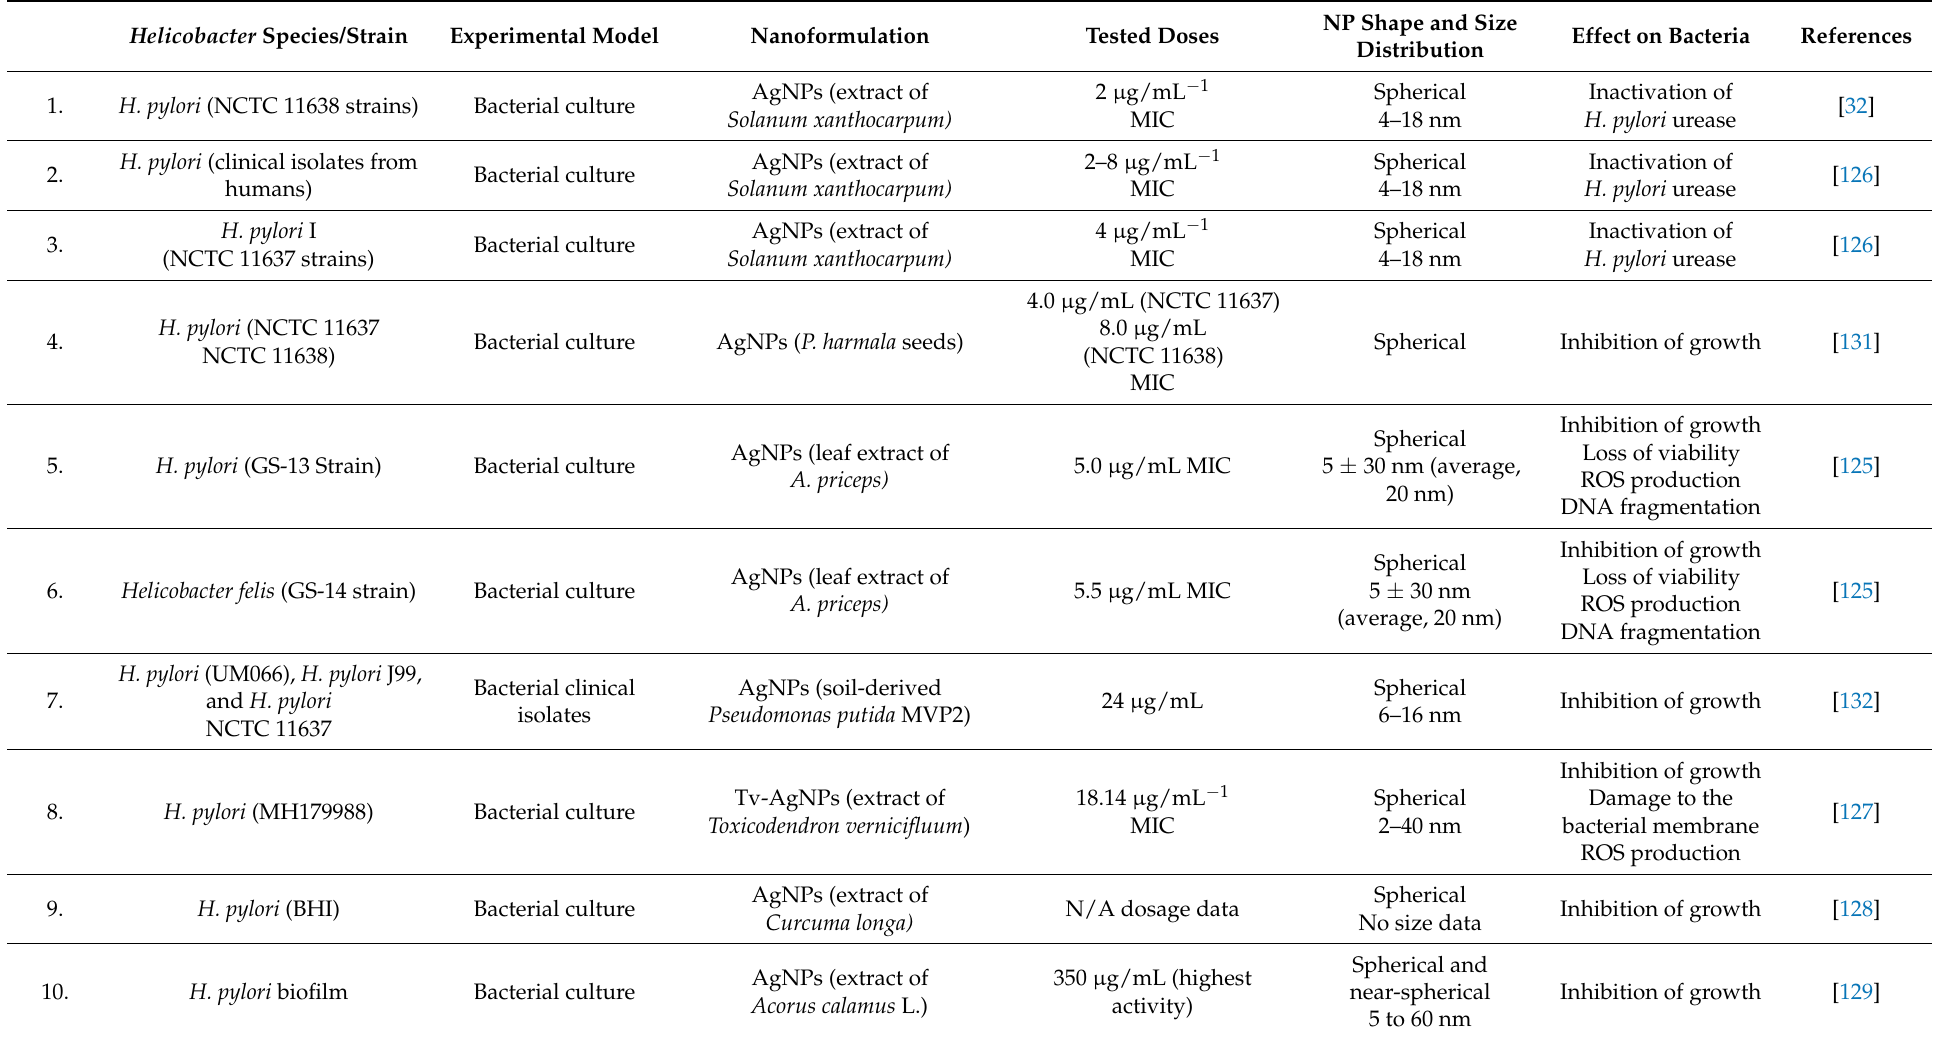
Table 2. Synopsis of the in vitro studies using AgNPs in the treatment of Helicobacter spp.-induced